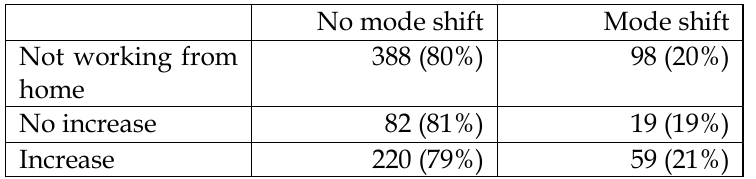
Crosstabulation of intention to work from home and intention to change the main commute mode (Data: MPN questionnaire, measurement of May 2022. N =